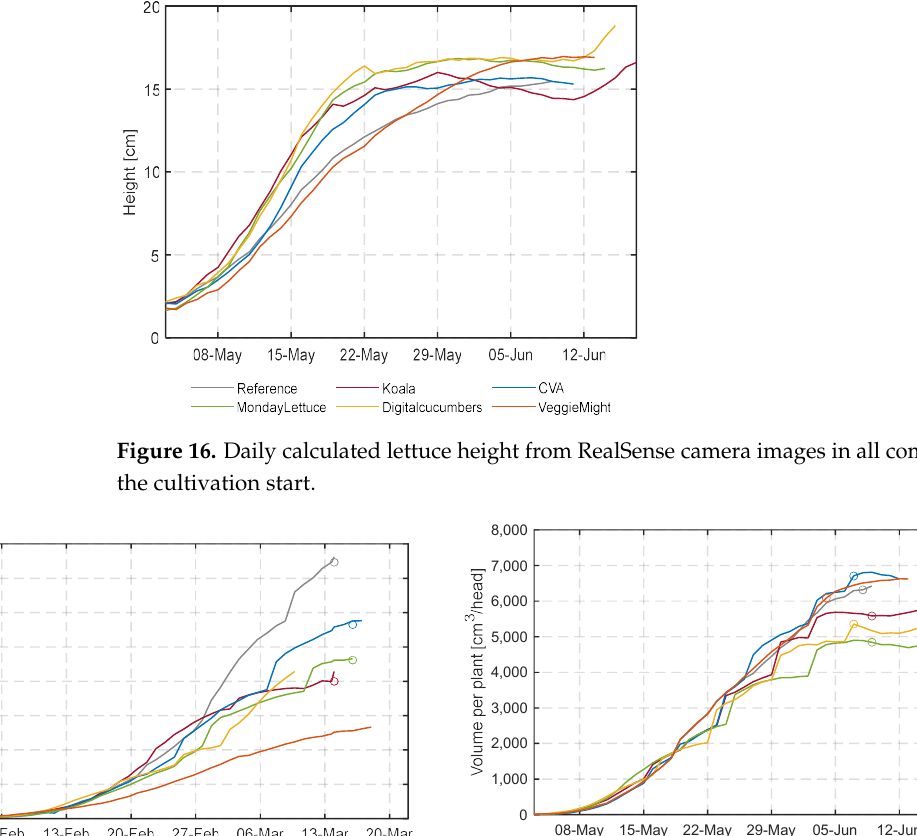
Figure 16. Daily calculated lettuce height from RealSense camera images in all compartments during the cultivation start.